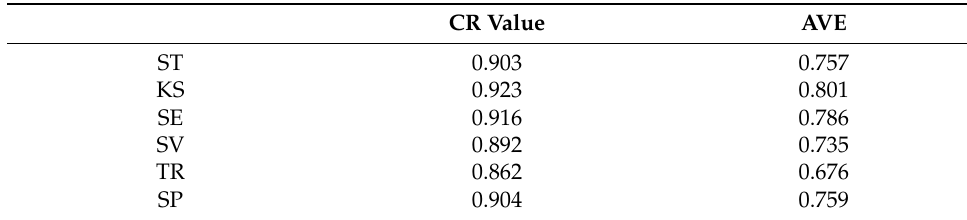
Table 6. Composite reliability test.